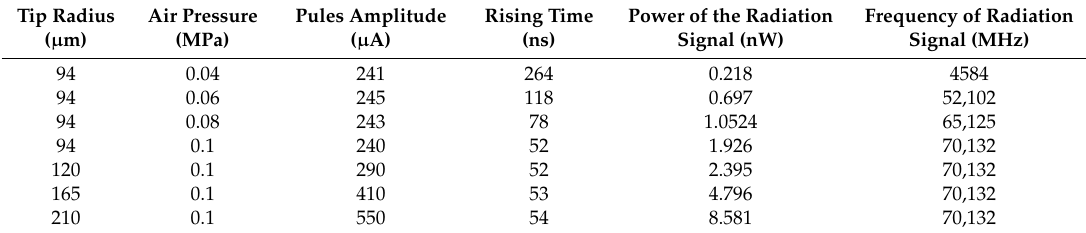
Table 1. Negative corona discharge Trichel pulse current and its radiation characteristics under different tip radius and different air